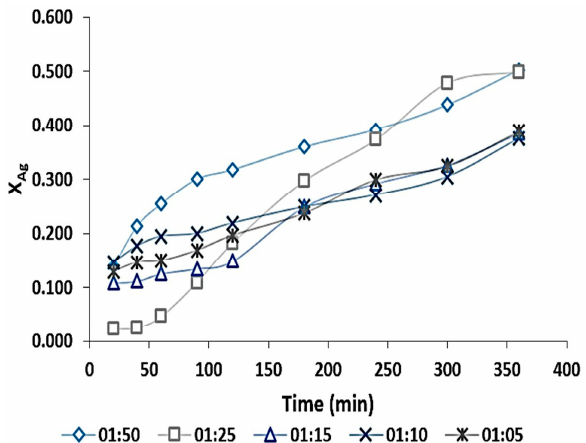
Figure 12. Graphical representation of the effect of the solid ‐ liquid ratio = 1:50, 1:25, 1:15, 1:10 and 1:05. V = 0.5 L, Mineral = 40 g · L − 1 , P O2 = 1 atm, pH = 9, t r = 360 min, d = 74 µ m, [S 2 O 3 2 − ] = 0.5 mol · L − 1 , [OH − ] = 0.1 mol · L − 1 , 298 K, RPM = 670 min − 1 .